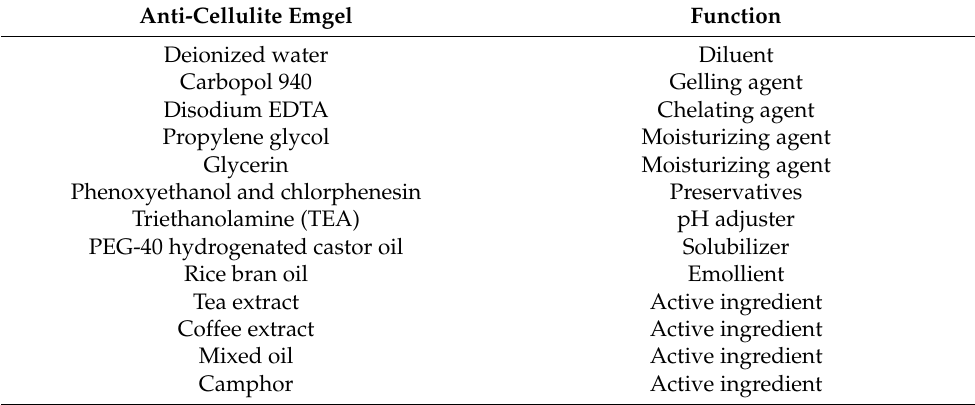
Table 11. Anti-cellulite emgel